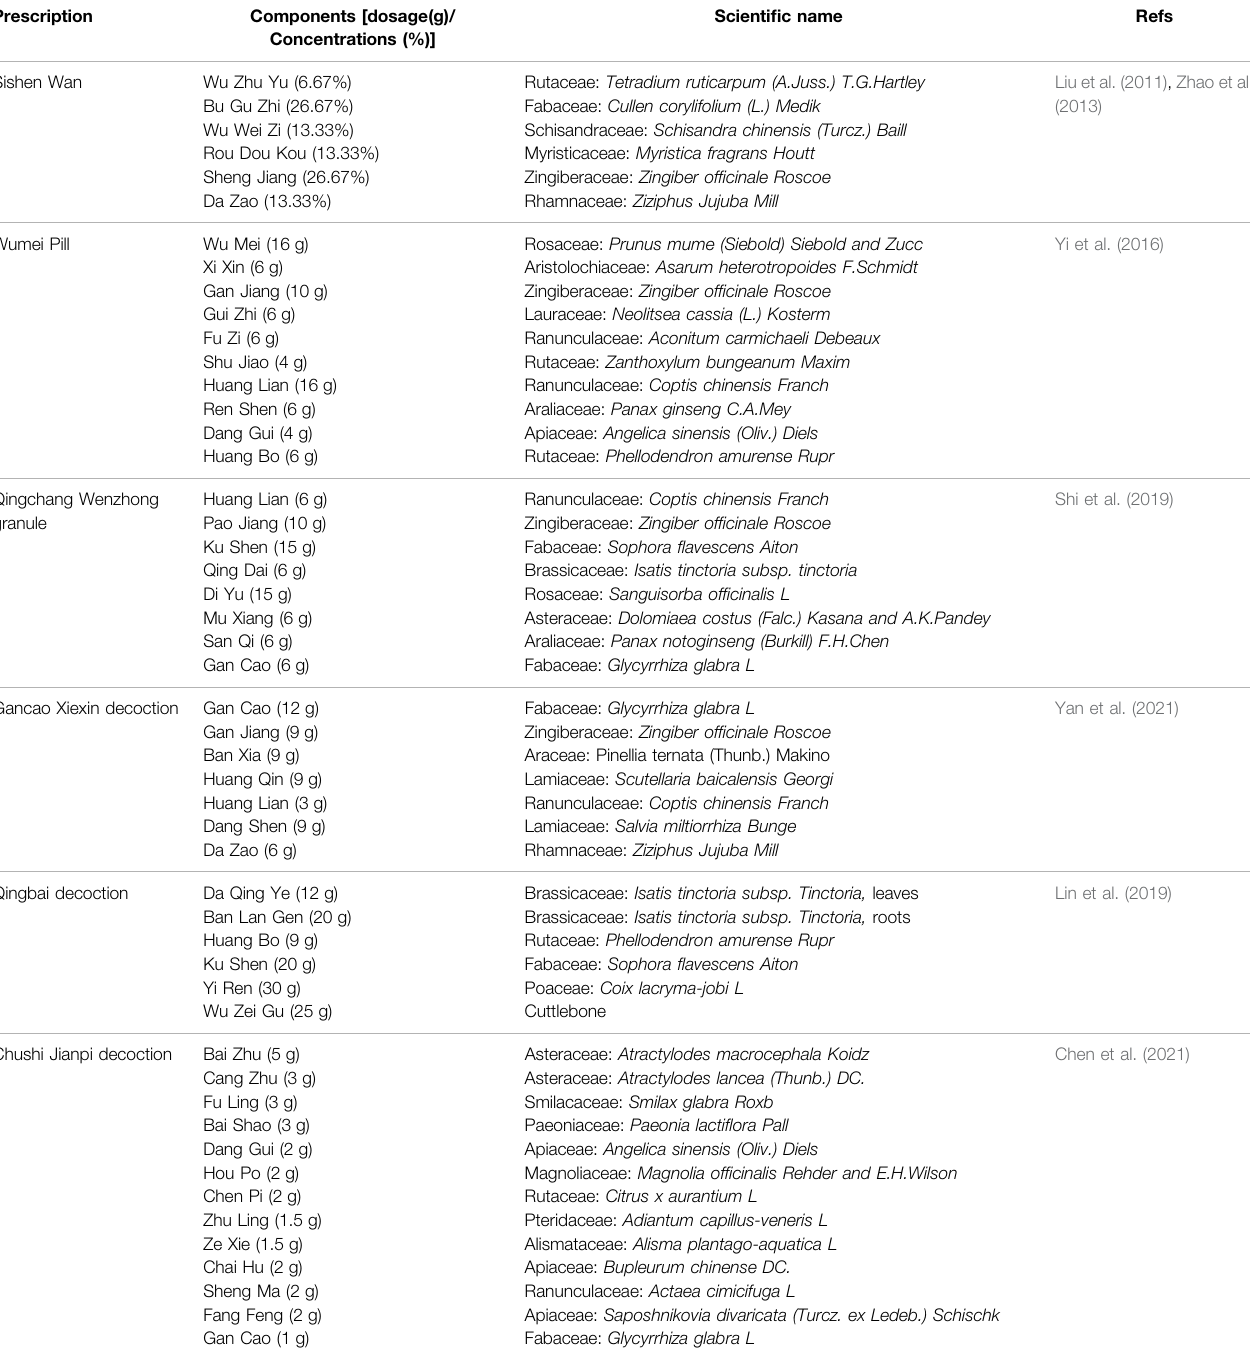
TABLE 2 | Components of TCM